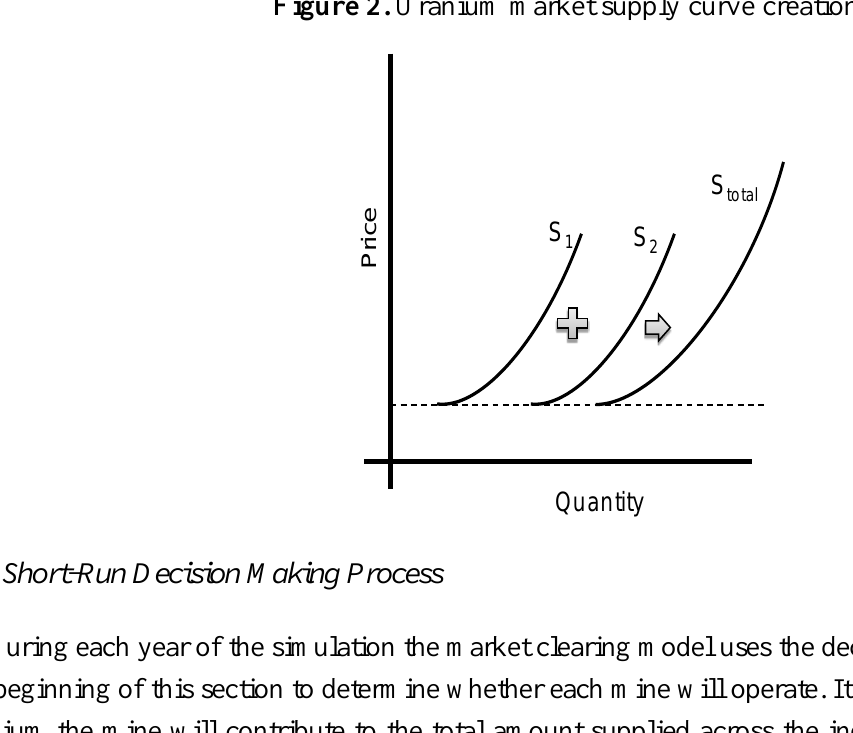
Figure 2. Uranium market supply curve